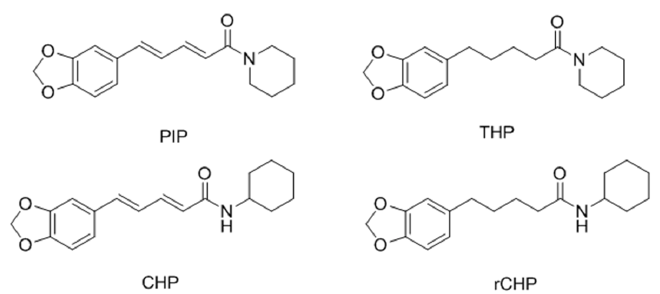
Figure 36. Structure of PIP and three analogues.